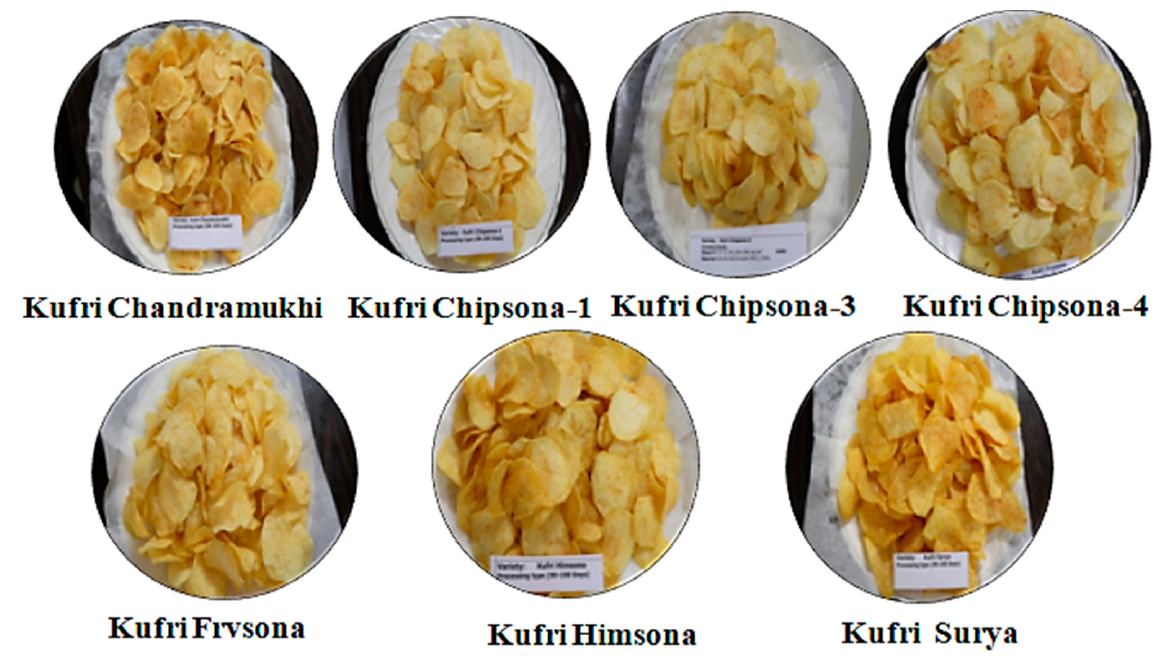
Figure 1. Chips colour of various processing type cultivar 15 days after frying. A positive correlation of dry matter content (Table 2) with specific gravity (r = 0.925 **) and starch content (r = 0.841 *) was observed in this study. Table 2 also indicated a